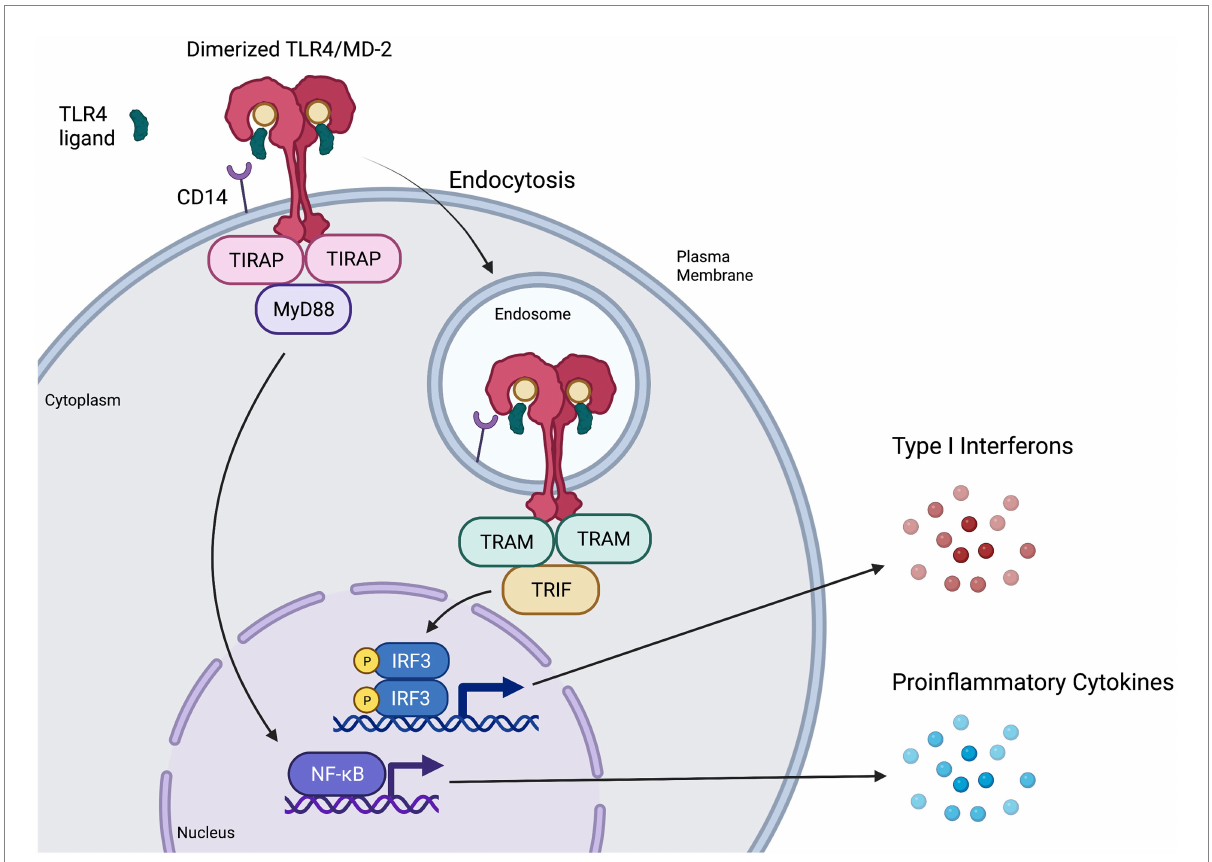
FIGURE 2 Representation of MyD88-dependent and-independent TLR4 signaling pathways. CD14 presents ligands such as LPS or RSV F protein to individual TLR4/MD-2 complexes, triggering them to dimerize and activate (Park and Lee, 2013; Kuzmich et al., 2017). The TIR domains of the dimerized TLR4/MD-2 complex interacts with TIR domains of the adaptor protein TIRAP (Kuzmich et al., 2017), which then recruits MyD88 to initiate the MyD88-dependent signaling pathway. This pathway results in NF- κ B activation and proinflammatory cytokine induction. Once the MyD88- dependent pathway has completed, the dimerized TLR4/MD-2 complex is internalized into an endosome (Kagan et al., 2008; Zanoni et al., 2011), a process that is thought to be at least partially mediated by CD14 and MD-2. Upon internalization, the adaptor protein TRAM interacts with the TIR domains of the dimerized TLR4/MD-2 complex and recruits TRIF, initiating the MyD88-independent (or TRIF-dependent) signaling pathway. The MyD88-independent pathway activates interferon regulatory factor (IRF3) leading to the production of type I interferons (IFN) and activation of interferon-stimulated genes